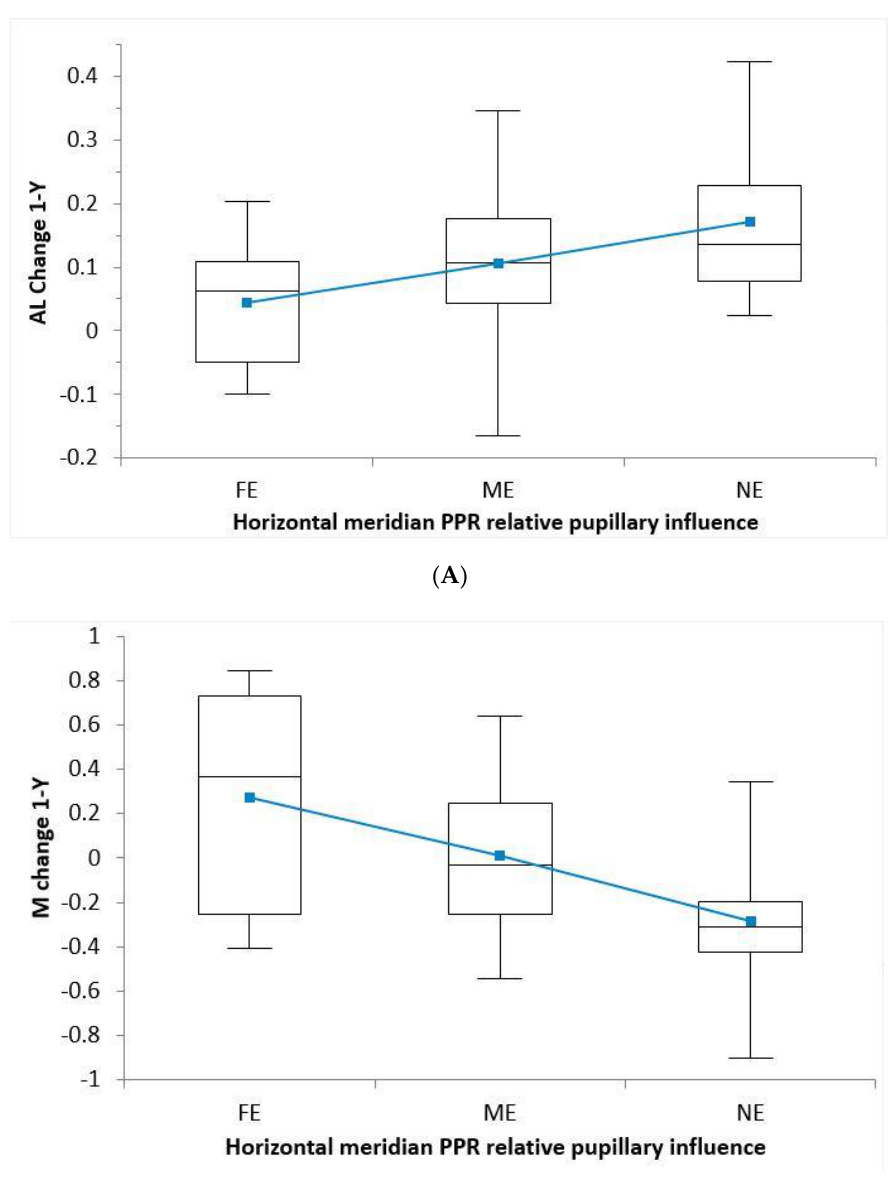
Figure 4. ( A ) The relative plus power ring diameter (PPRD)/pupillary effect for horizontal meridian to axial length (AL) at one year change. Vertical meridian PPRD and mean PPRD resulted in a very similar image. The group with a full effect (FE) had a pupillary diameter larger than the PPRD + 0.9 mm, the group with medium effect (ME) had a pupil between the PPRD ± 0.9, and the No Effect (NE) group had a pupillary diameter smaller than the PPRD − 0.9 mm. ( B ) The relative plus power ring diameter (PPRD)/pupillary effect for horizontal meridian related to spherical refraction (M) at 12 month increase. Vertical meridian PPRD and mean PPRD resulted in a very similar image and was not plotted. In figure A and B, a trend toward a dose-dependent PPRD is observed. The mean values are represented by small squares (blue); medians are shown by flat lines, 1st and 3rd quartile interval boxes; and the minimal and maximal values are